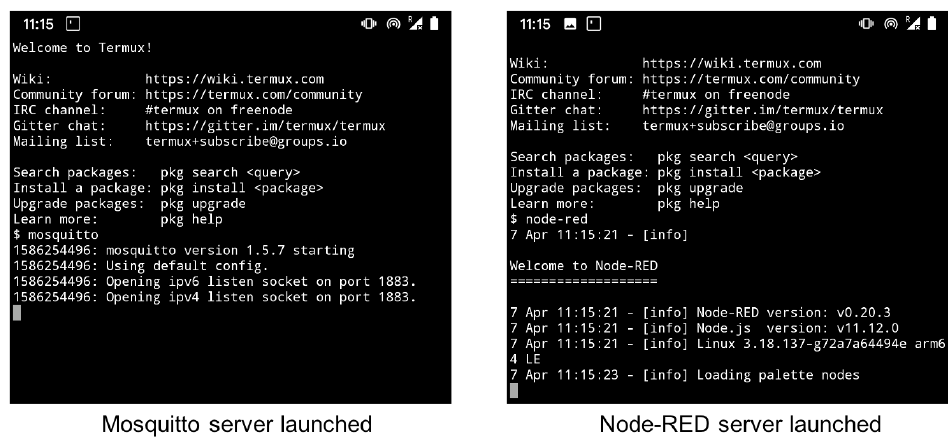
Figure 6. Screen capture of servers launched on Android